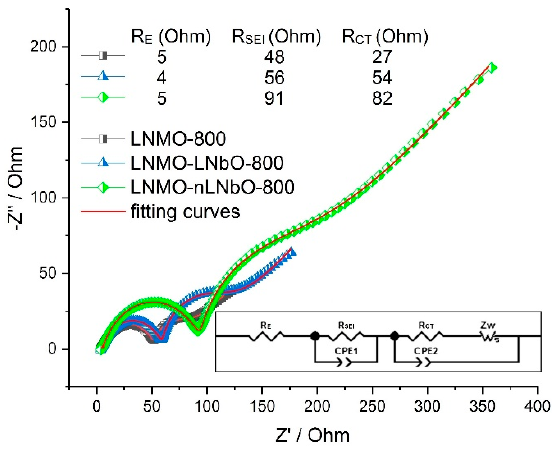
Figure 6. Electrochemical impedance spectra (EIS) plots after five cycles of pristine sample calcined at 800 °C (LNMO-800), coated using sol-gel method (LNMO-LNbO-800) and new method (LNMO-nLNbO-800) and calcined at 800 °C. Inset: the equivalent circuit for EIS results fitting .